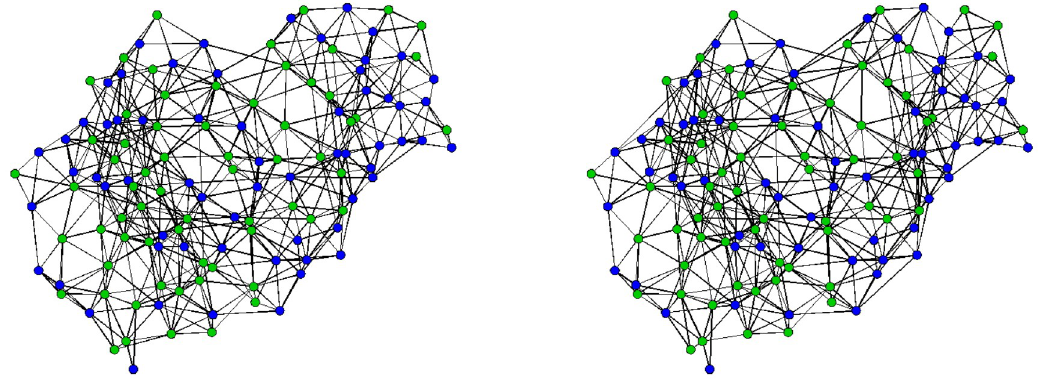
Fig 3. 2D representation of Lysozyme structure networks (PDB 1AKI [104]; Left), (PDB 1BHZ [105]; Right). Colors distinguish nonpolar (green) versus polar (blue) residues; node coordinates determined via topology and are not based on physical